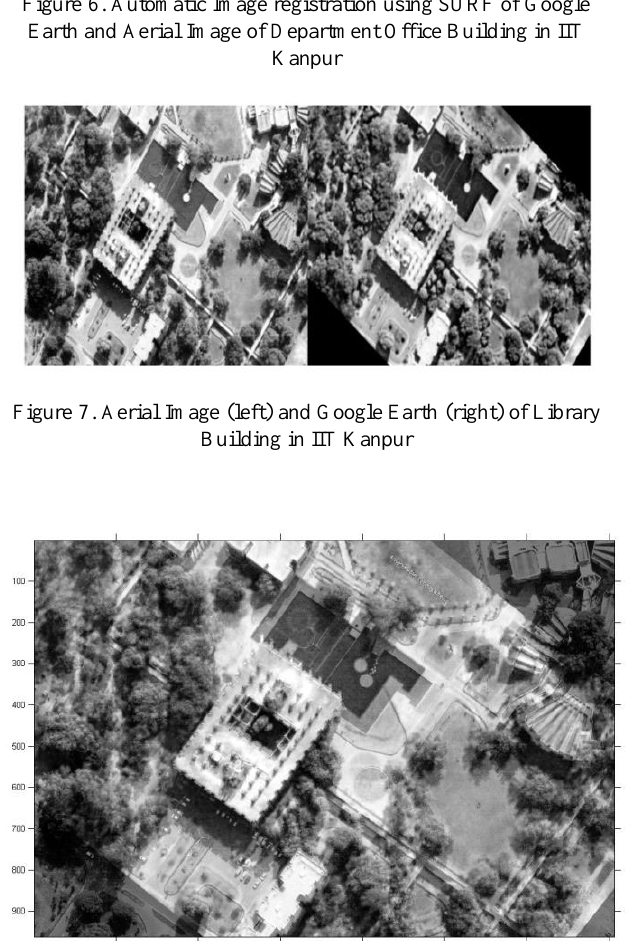
Figure 6. Automatic Image registration using SURF of Google Earth and Aerial Image of Department Office Building in IIT